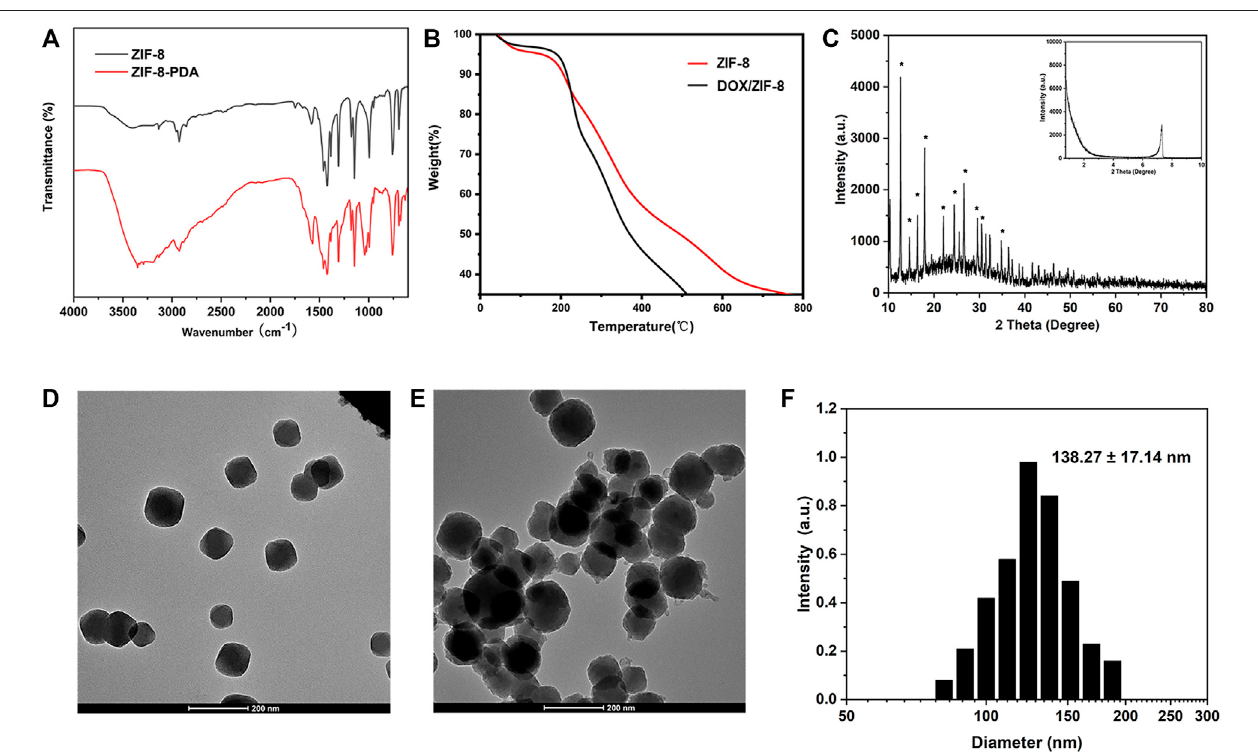
FIGURE1|(A) FT-IR spectraofZIF-8and ZIF-8/PDA. (B) TGAcurves ofZIF-8 and DOX/ZIF-8. (C) XRDcharacterization ofZIF-8. Themain peaksarelabeledwith stars. (D,E) DOX/ZIF-8 and DOX/Ce6@ZIF-8@PDATEM images. (F) DZCP diameter distribution in